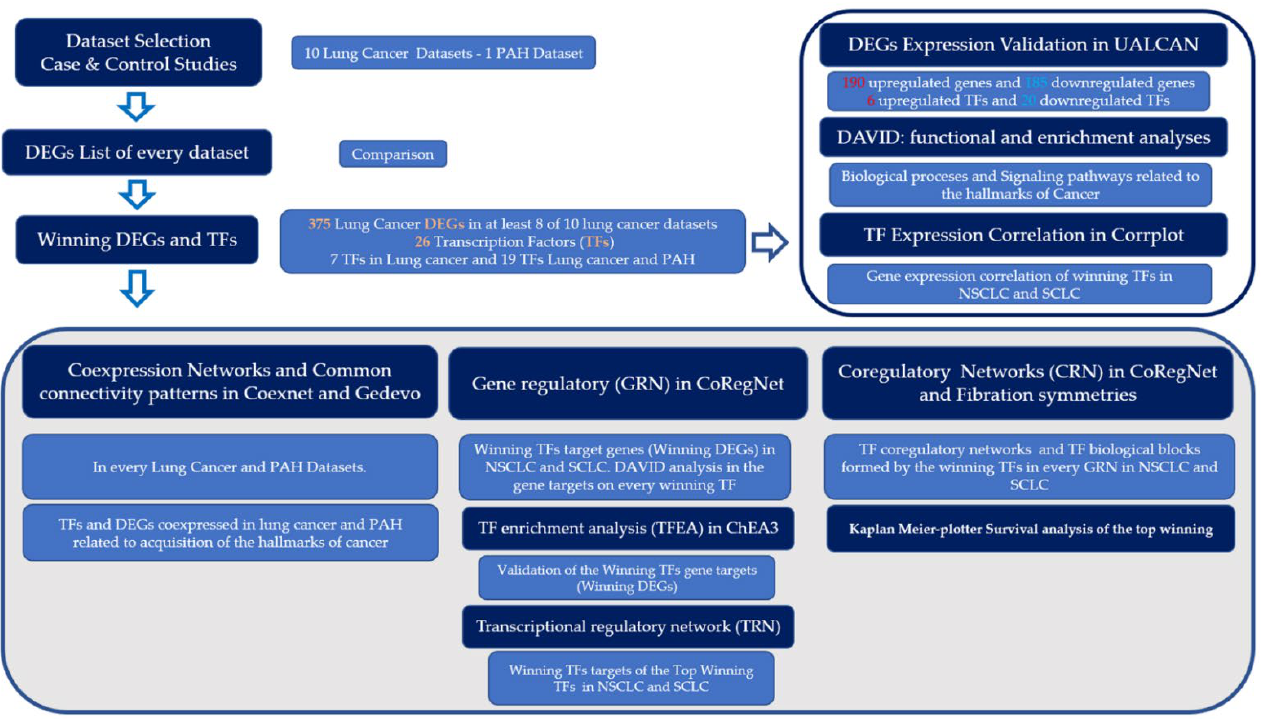
Figure 1. Bioinformatic pipeline for the construction of a lung cancer gene regulatory network of transcription factors related to the hallmarks of cancer.